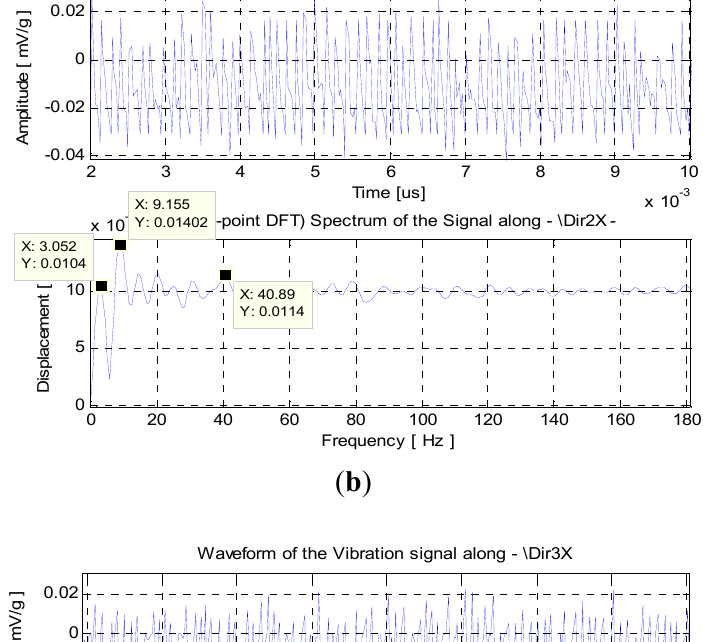
; ( c ) Signal at position P 2